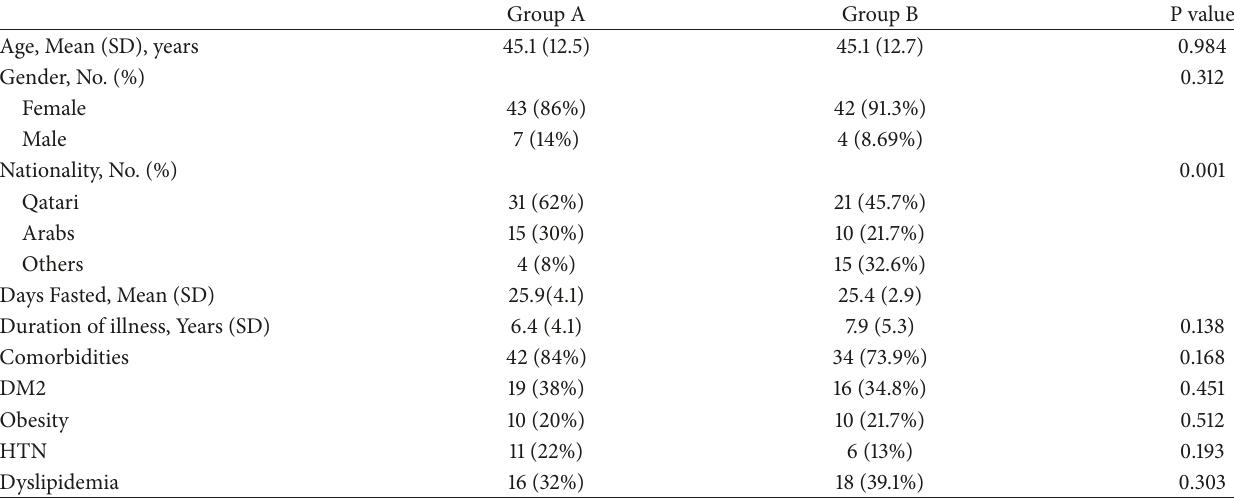
Table 1: Demography of the study population.